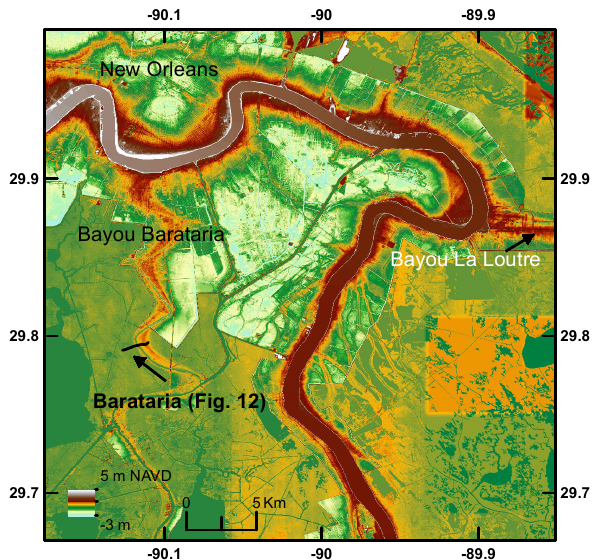
Figure 11. Digital elevation map (NED 1/3arcsec) of the Barataria area (for location see Fig. 1b) with the location of cross section Barataria (Fig. 12).